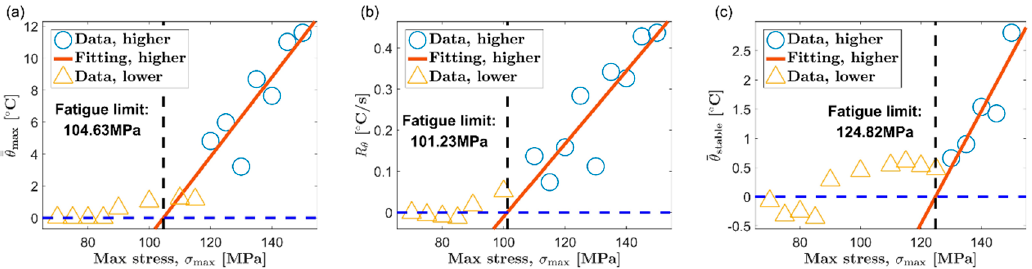
Figure 12. Fatigue limit evaluation using the Risitano method, ED: ( a ) maximum temperature rise, θ max ; ( b ) initial temperature rise slope, R θ ; ( c ) mean temperature rise of stable phase,